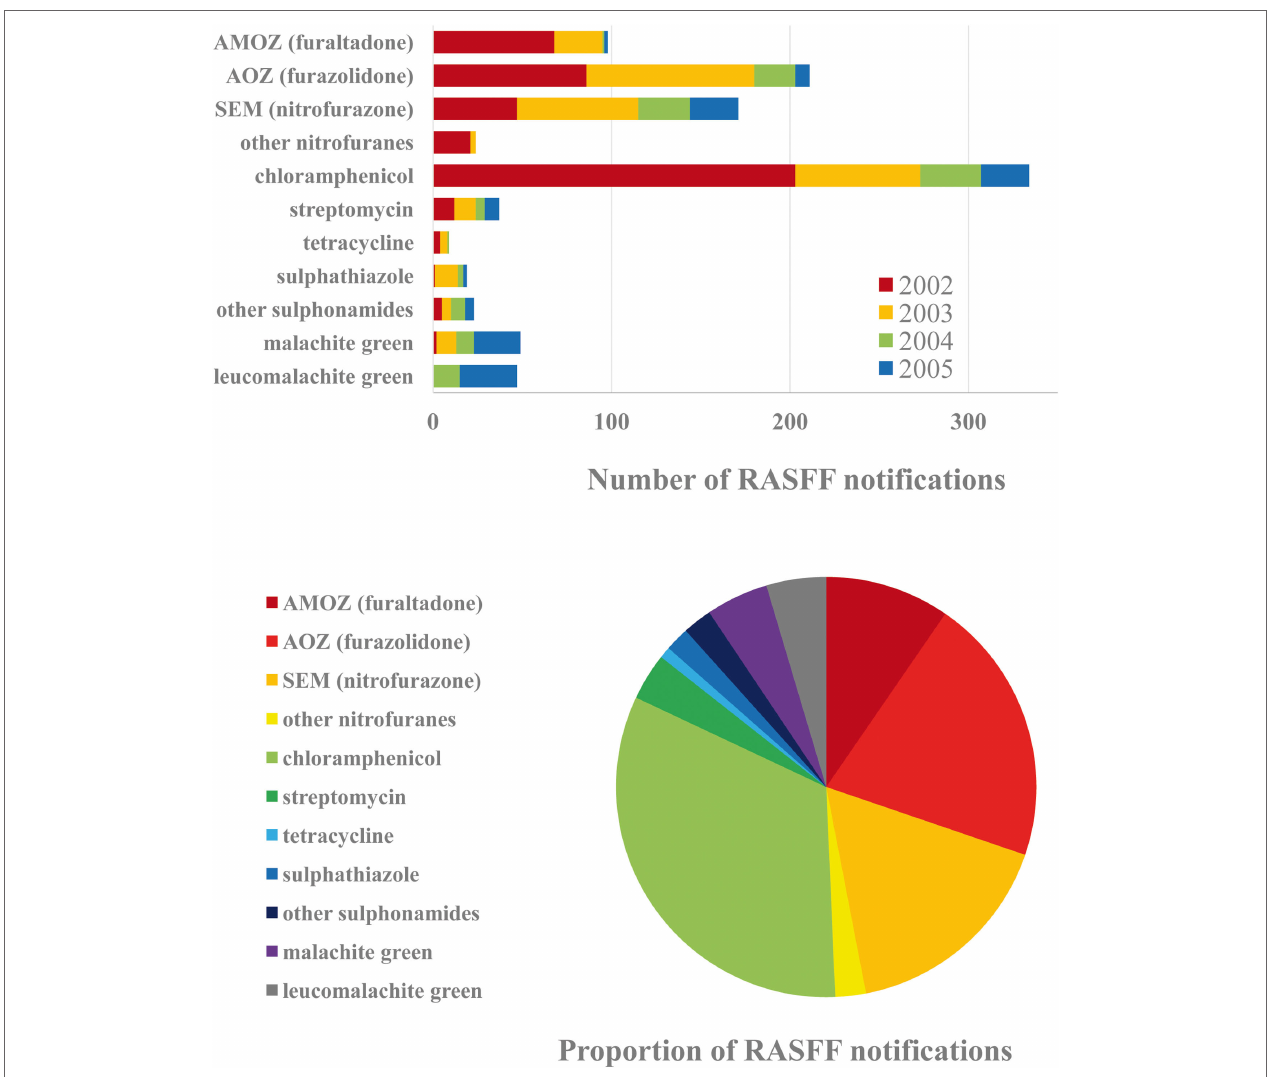
FiGURe 2 | Frequently reported active ingredients of veterinary drug (VD) residues in the Rapid Alert System for Food and Feed (RASFF) database in the corresponding critical period, 2002–2005 (above). Proportions of the VDs reported during the 4-year period